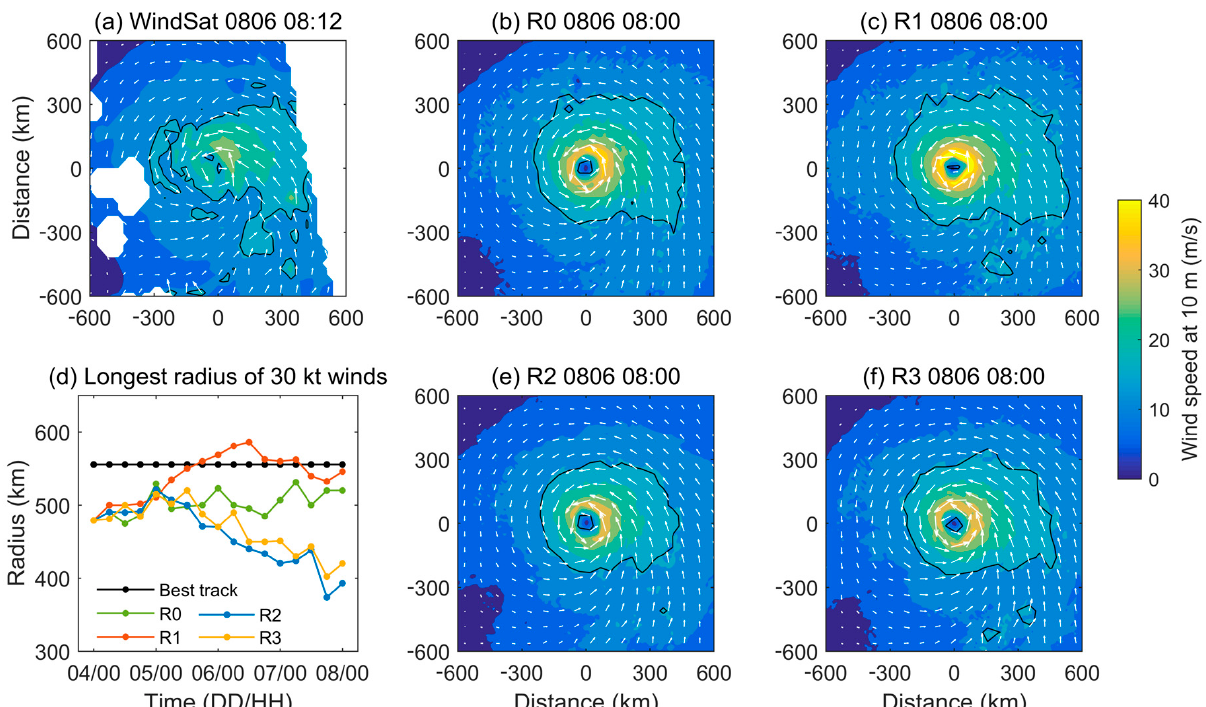
Figure 4. Shanshan wind speeds at 10 m above the sea surface. ( a ) WindSat wind speed observations at 08:12 UTC on 6 August, 2018; ( b , c , e , f ) simulated wind speeds from four different numerical experiments at 08:00 UTC on 6 August, 2018; ( d ) longest radius of 30 kt (15.4 m/s) from JMA best track data and four different numerical experiments at 6-hourly intervals from 00:00 UTC 4 August through 00:00 UTC 8 August 2018. Black lines in panels ( a – c , e , f ) represent the 15.4 m/s isotach. See Table 1 for details of the different numerical experiments.